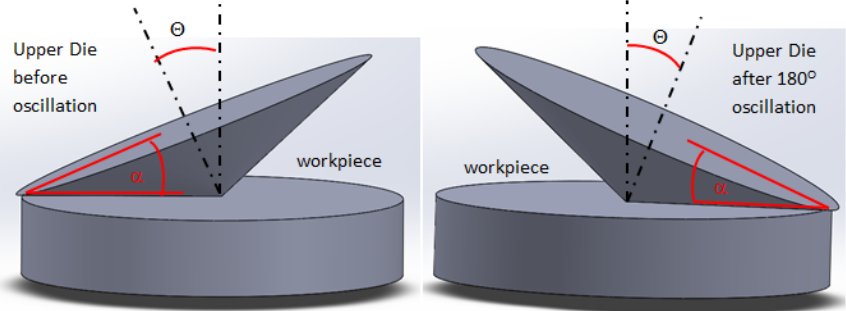
Figure 3: Concept of Rotary